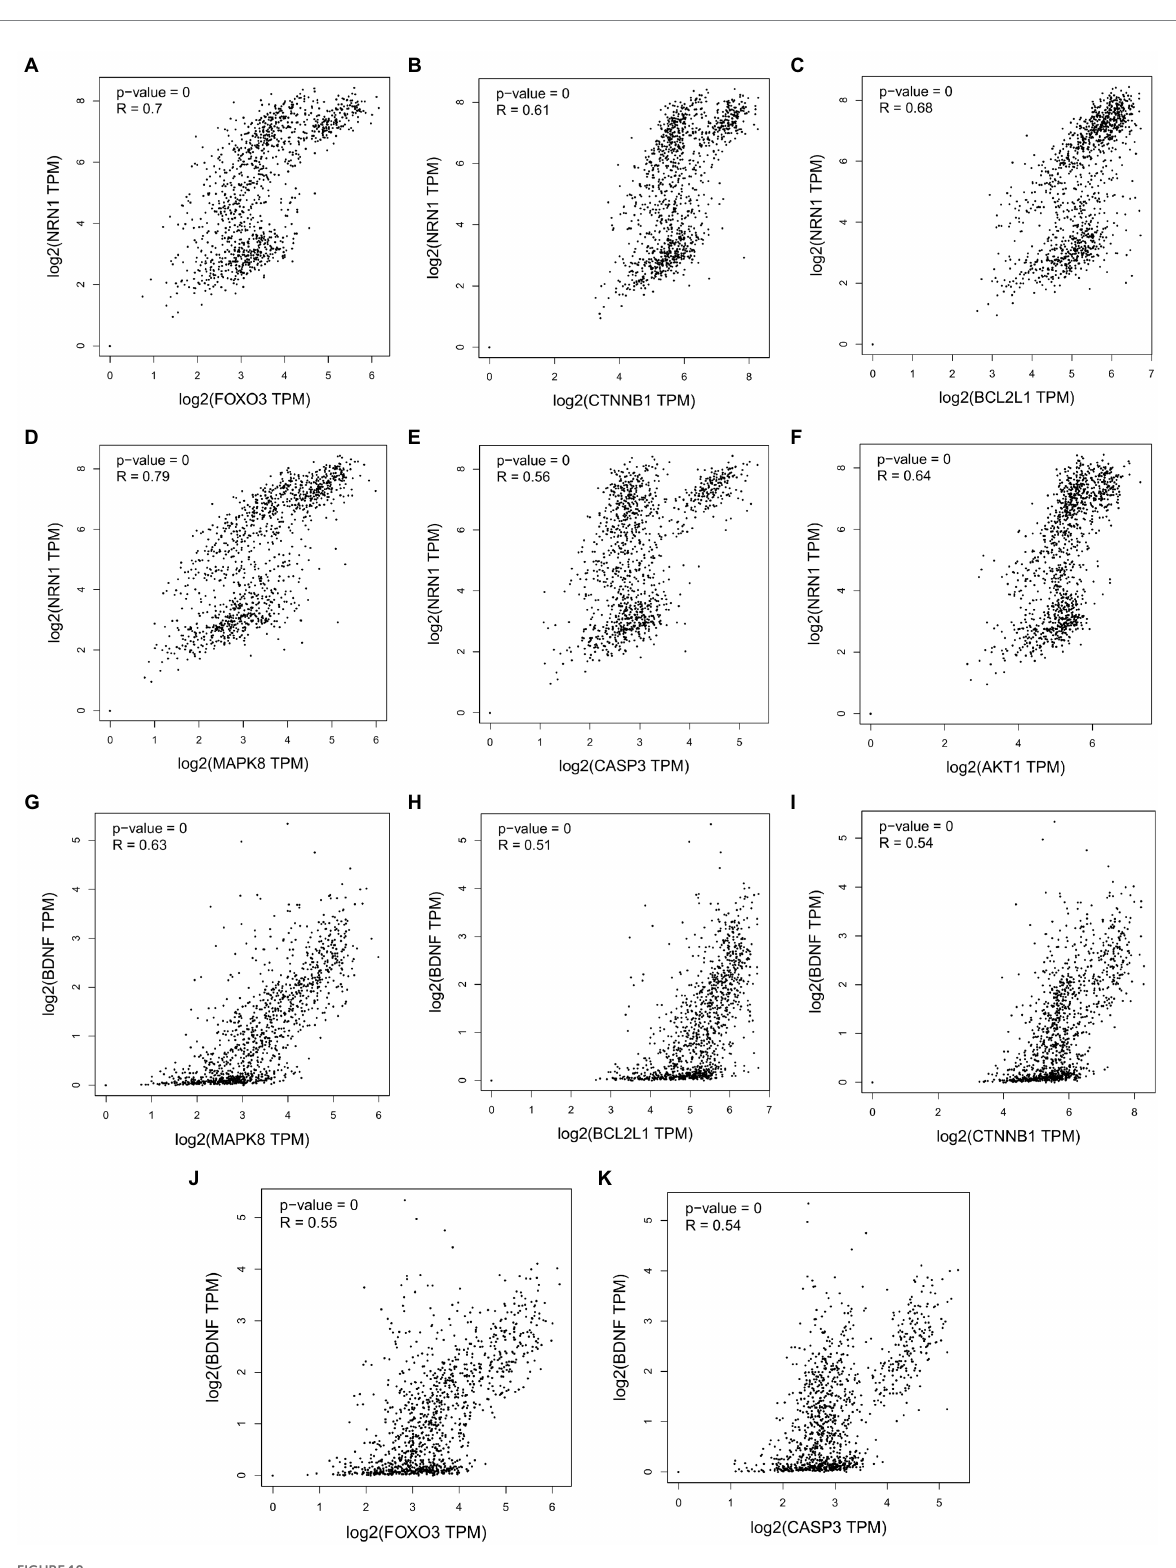
FIGURE 10 Correlation analysis between cordycepin key targets and neurotrophin NRN1 (A–F) ; correlation analysis between cordycepin key targets and neurotrophin BDNF (G–K)